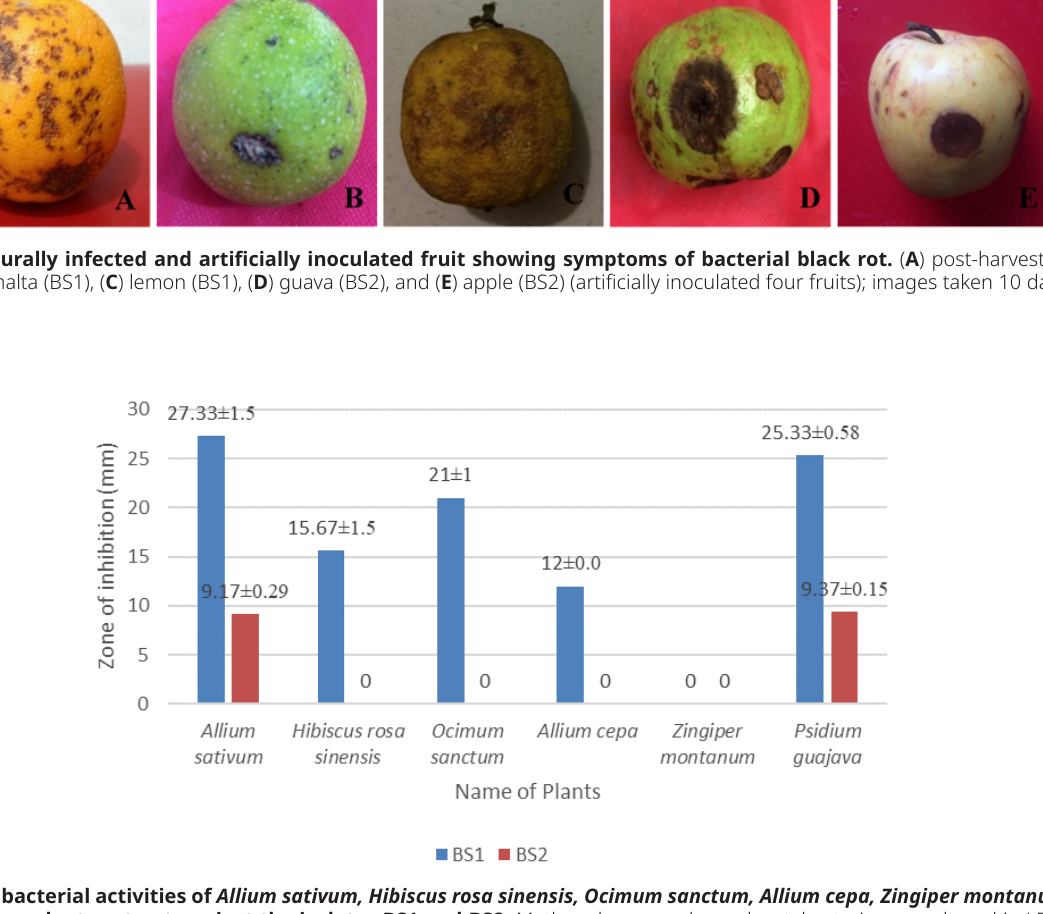
Figure 4. Antibacterial activities of Allium sativum, Hibiscus rosa sinensis, Ocimum sanctum, Allium cepa, Zingiper montanum, and Psidium guajava plants extract against the isolates BS1 and BS2. Methanol was used as solvent, bacteria was cultured in LB, plated were incubated at 37°C for 18